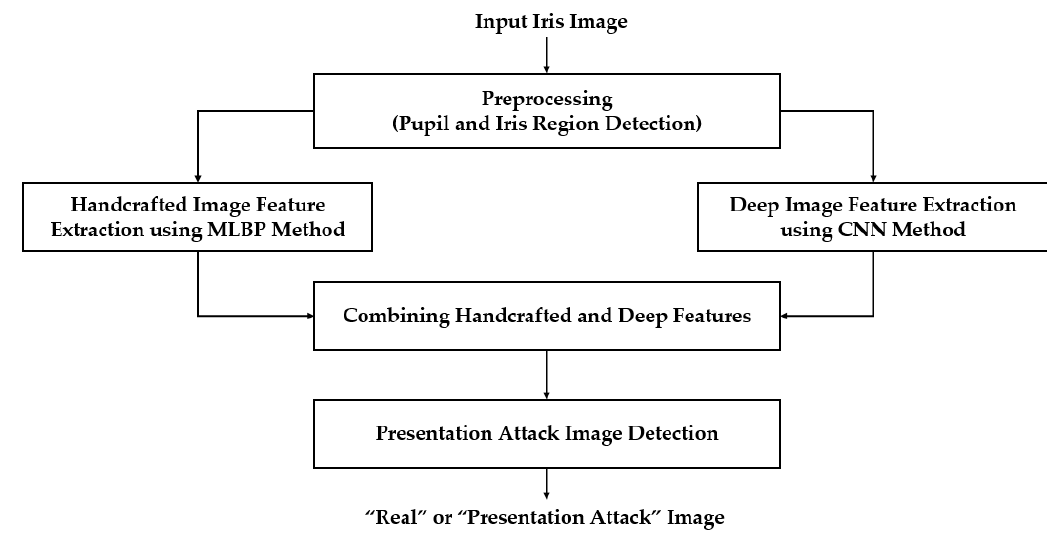
Figure 1. General flowchart of proposed iPAD method.